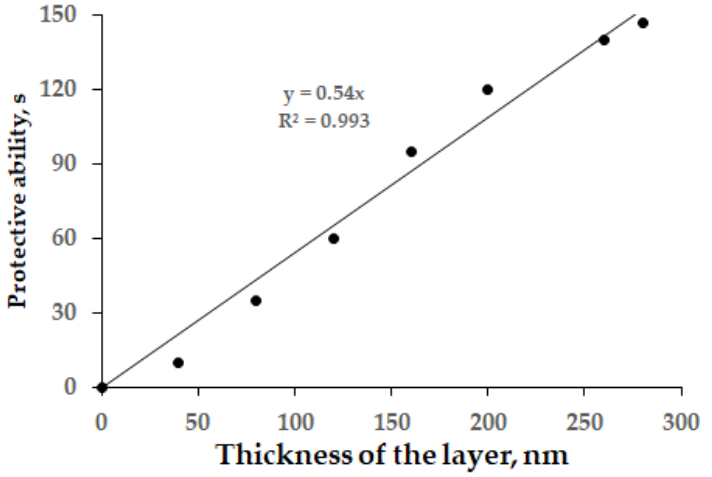
Figure 10. Correlation between the protective ability of the stearate coating on the surface of the AMg6 alloy and its thickness.